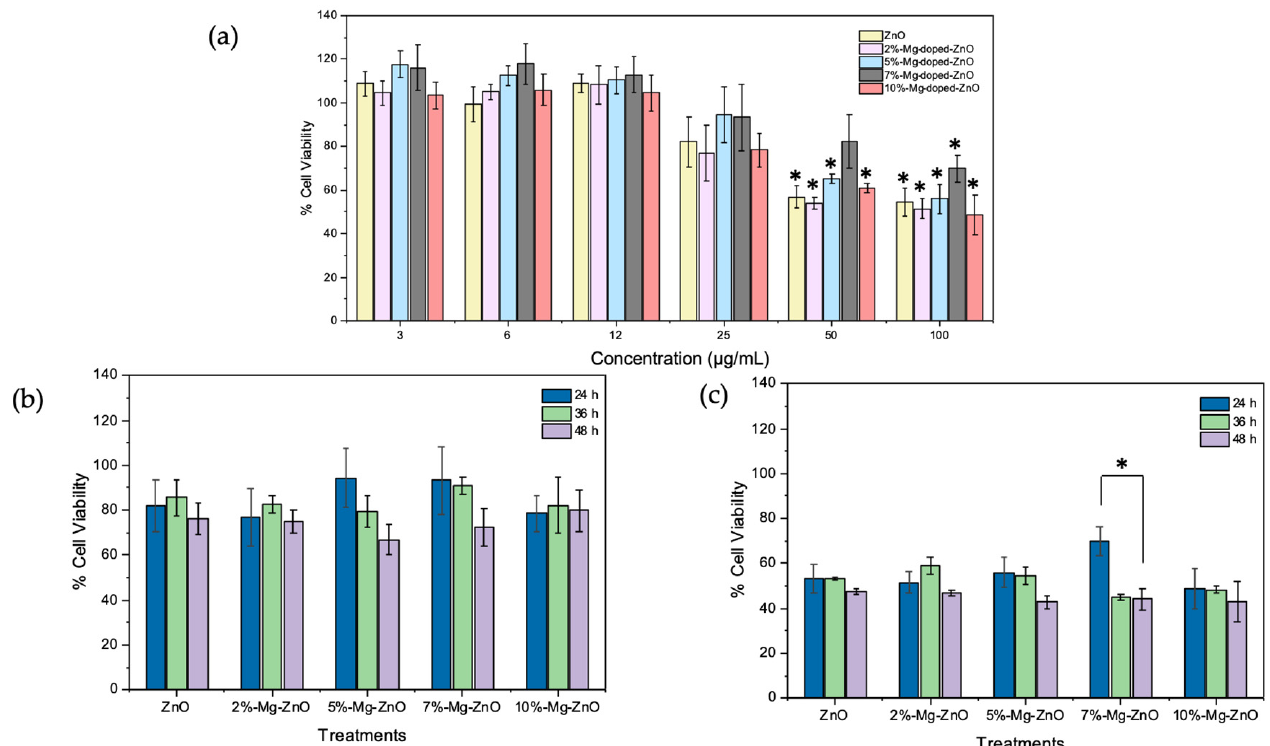
Figure 6. ( a ) Effect of ZnO nanoparticles and Mg ‐ doped ZnO nanoparticles on the viability of MCF ‐ 7 cells after 24 h, as determined by MTT assay. It was found that high doses, e.g., 50 and 100 μ g/mL, show significant cytotoxicity; ( b ) viability of MCF ‐ 7 cells treated with 25 μ g/mL ZnO nanoparticles and Mg ‐ doped ZnO nanoparticles for 24 h, 36 h, and 48 h; ( c ) viability of MCF ‐ 7 cells treated with 100 μ g/mL ZnO nanoparticles and Mg ‐ doped ZnO nanoparticles. Cell viability was measured after 24 h, 36 h, and 48 h by MTT assay. Data are represented as the mean of triplicate ± SEM (* p < 0.05).